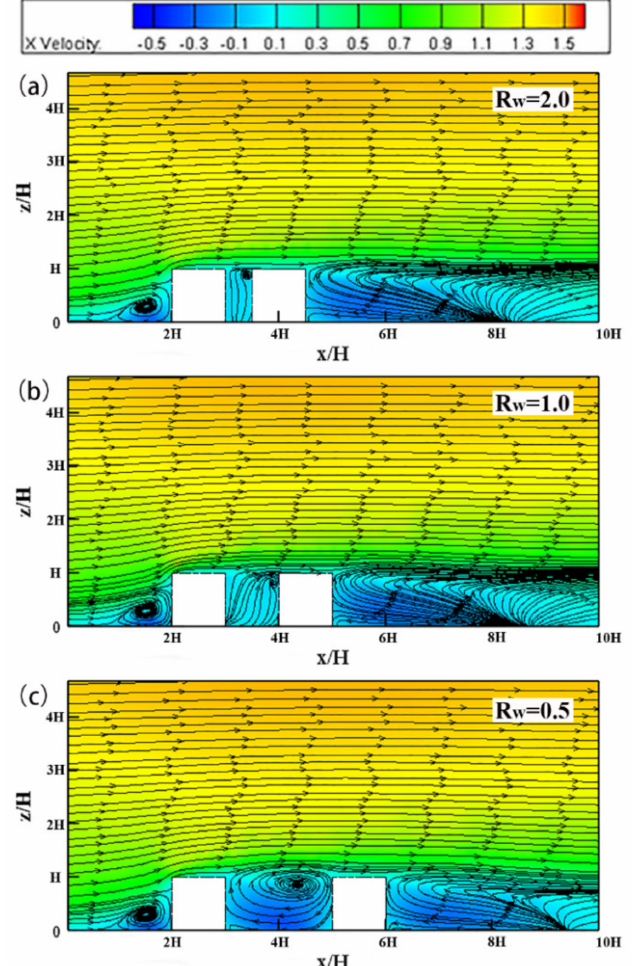
Figure 7. Time-averaged streamlines and flow velocity contours on the vertical plane (y = 0) of streets with different aspect ratios: ( a ) R w = 2.0; ( b ) R w = 1.0; ( c ) R w =